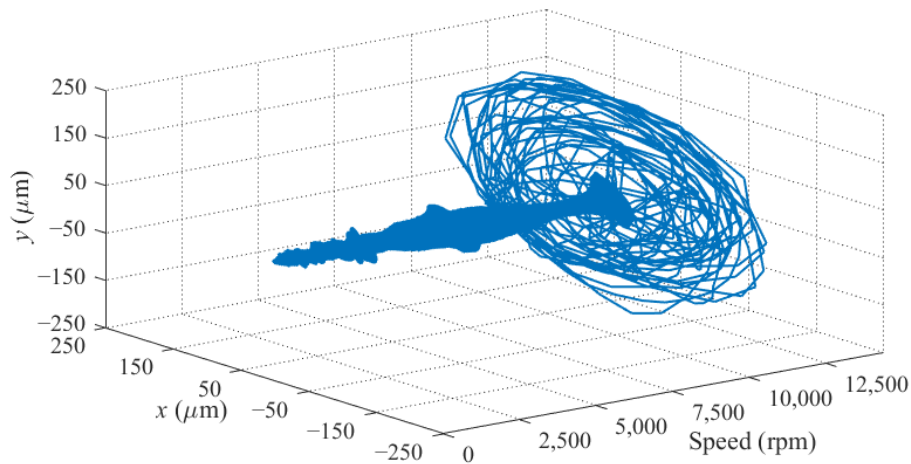
Figure 15. Rotor trajectory during running up with the PID controller. Furthermore, the µ -controller is implemented to replace the PID controller. The levitation response test of the µ -controller is first conducted, the rotor orbit is shown in Figure 16. The rotor levitates from the auxiliary bearing and reaches the equilibrium position in less than 0.05 s, and the overshoot is less than ± 80 µ m, which shows good transient performance of the controller. After stable levitation, it has high steady-state precision, within ± 5 µ m.